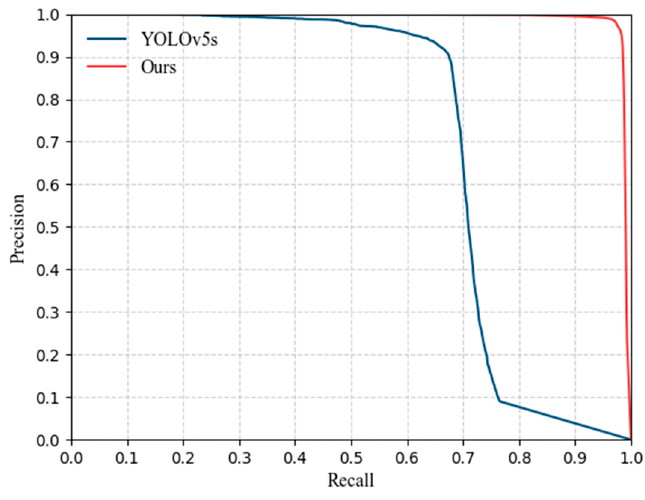
Figure 8. PR curves of the proposed algorithm and YOLOv5s.